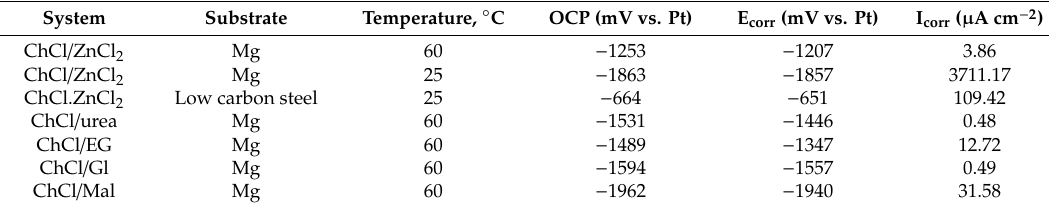
Table 3. The electrochemical parameters obtained from the polarization of Zn deposition in di ff erent ionic liquids on di ff erent substrates